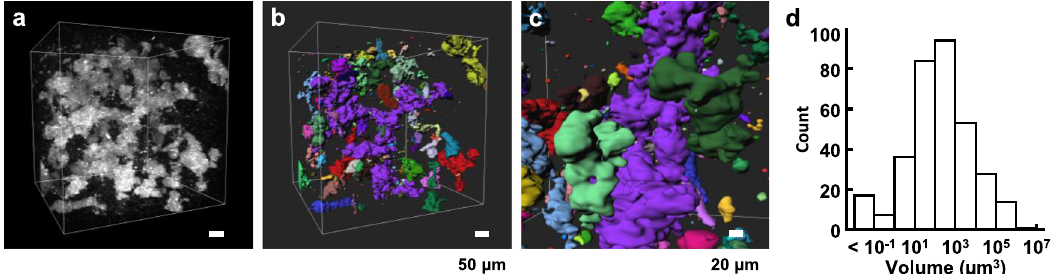
Fig. 6 Volumetric analysis of a 3D image. a 3D rendering of gluten in a 12%-NaCl noodle. Note, the 3D data set shown in this fi gure is the same as that in Fig. 5m. b Surface rendering by binarising the fl uorescence intensity of ( a ). Each gluten clump that is three dimensionally isolated from others is displayed in a different colour in ( b ). c Image rendered from different viewpoints of the 3D image shown in ( b ). Scale bars indicate 50 µ m ( a , b ) and 20 µ m ( c ). d Volume distribution of gluten shown in ( b ). Source data underlying ( d ) are provided as a Source Data fi